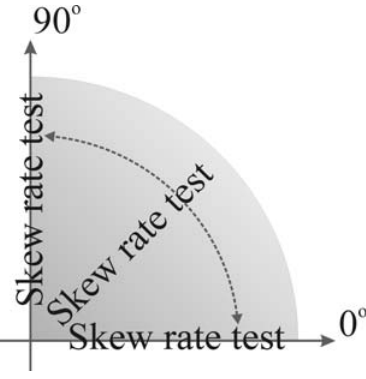
Figure 6. Sample text rotated up to 90° in 5°